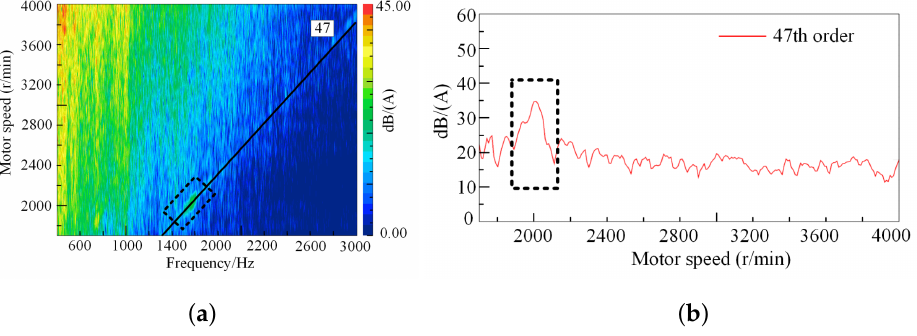
Figure 5. ( a ) Color map graph under the second gear acceleration condition; ( b ) 47th order noise under the second gear acceleration